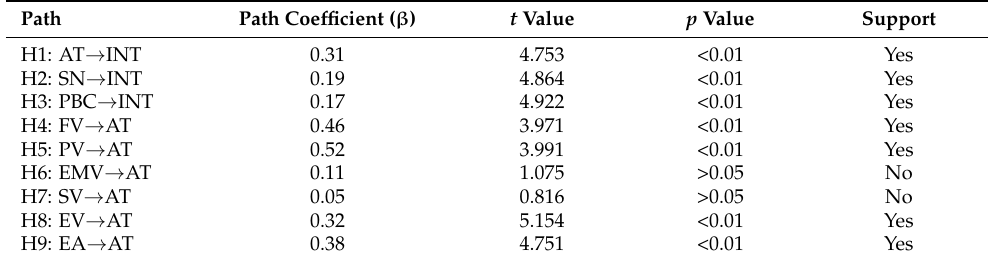
Table 6. Structural model results.